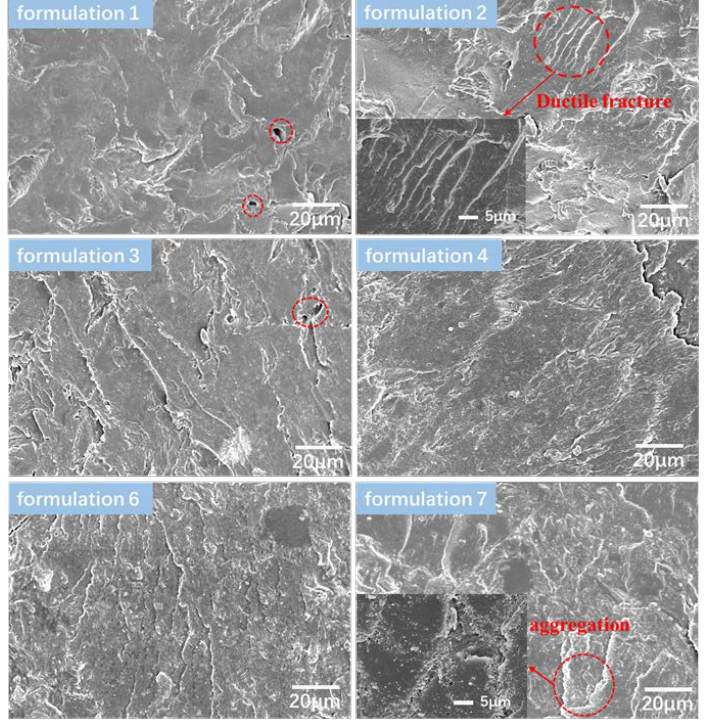
Figure 4. DSC curves of investigated adhesives.